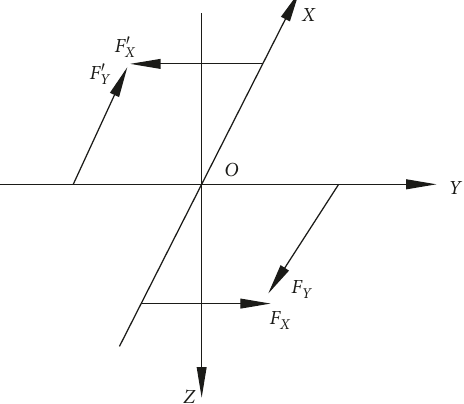
Figure 5: The force diagram of the Hooke